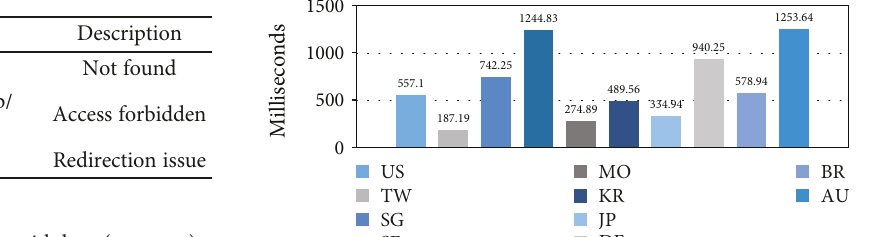
Table 4: Test result of the emulation mode with hop (coverage). Number of tested resources 101 Total number of found resources